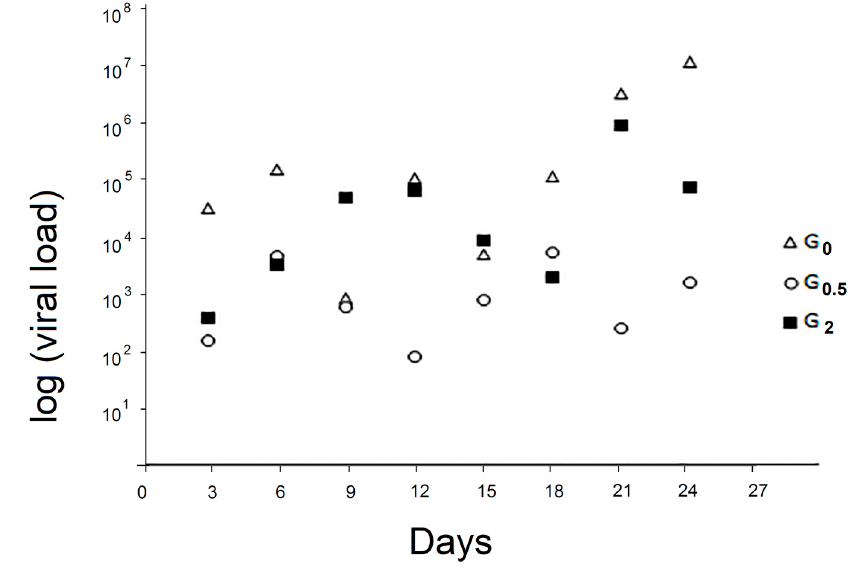
Figure 2. Viral load in the faecal samples. In G 0 , G 0.5 , and G 2 , are grouped bees fed with 0%, 0.5%, and 2% of 1,3-1,6 β -glucans (w/w) in syrup, respectively. Values were expressed as exponential